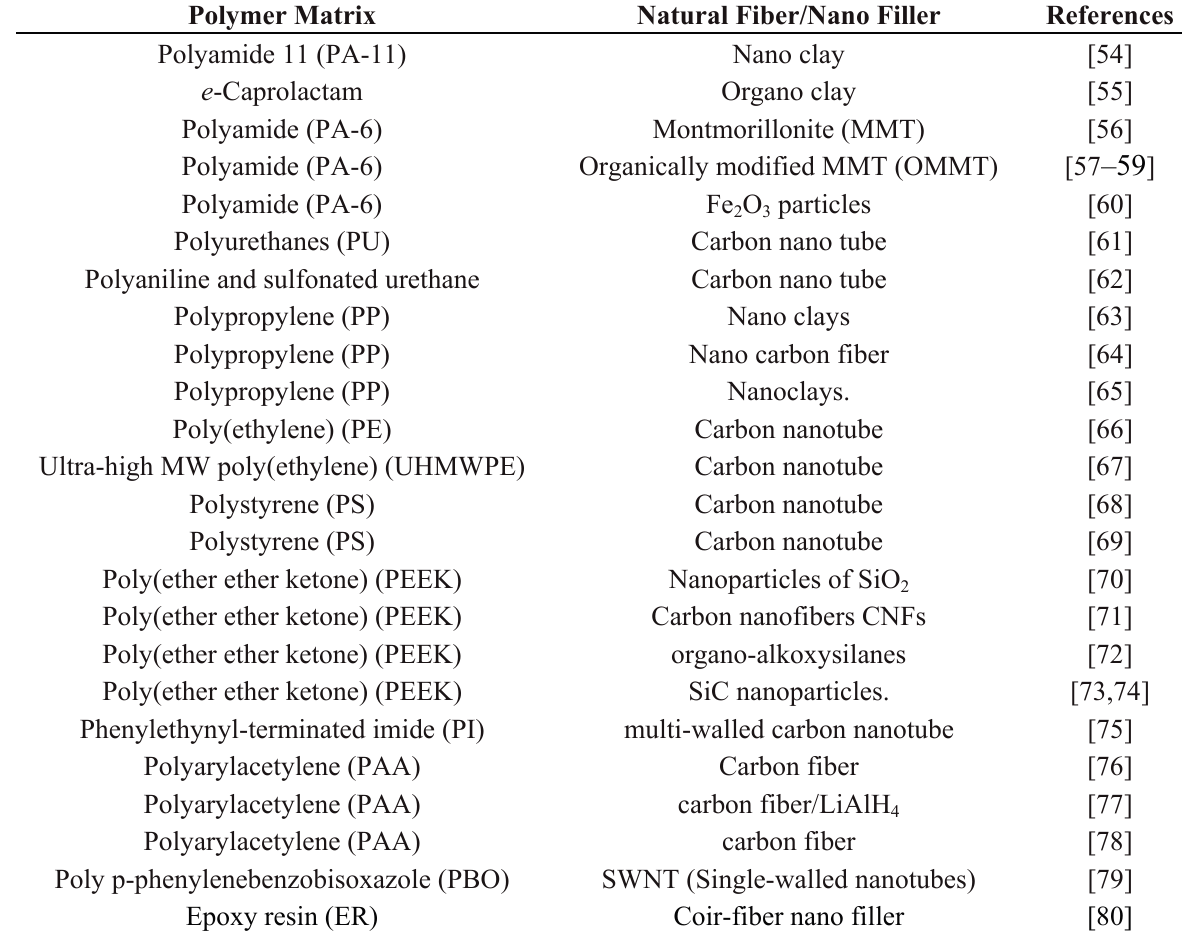
Table 8. List of reported work on nanocomposite type from different polymeric matrix with natural